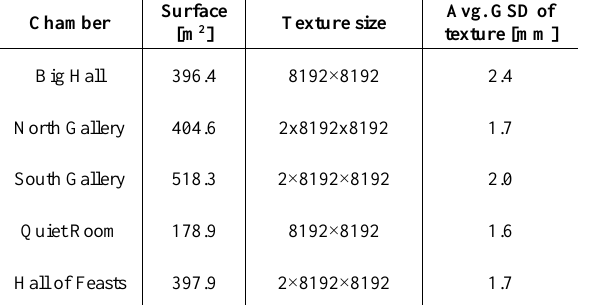
Table 3. Area of each chamber compared with texture size and GSD of final textures.